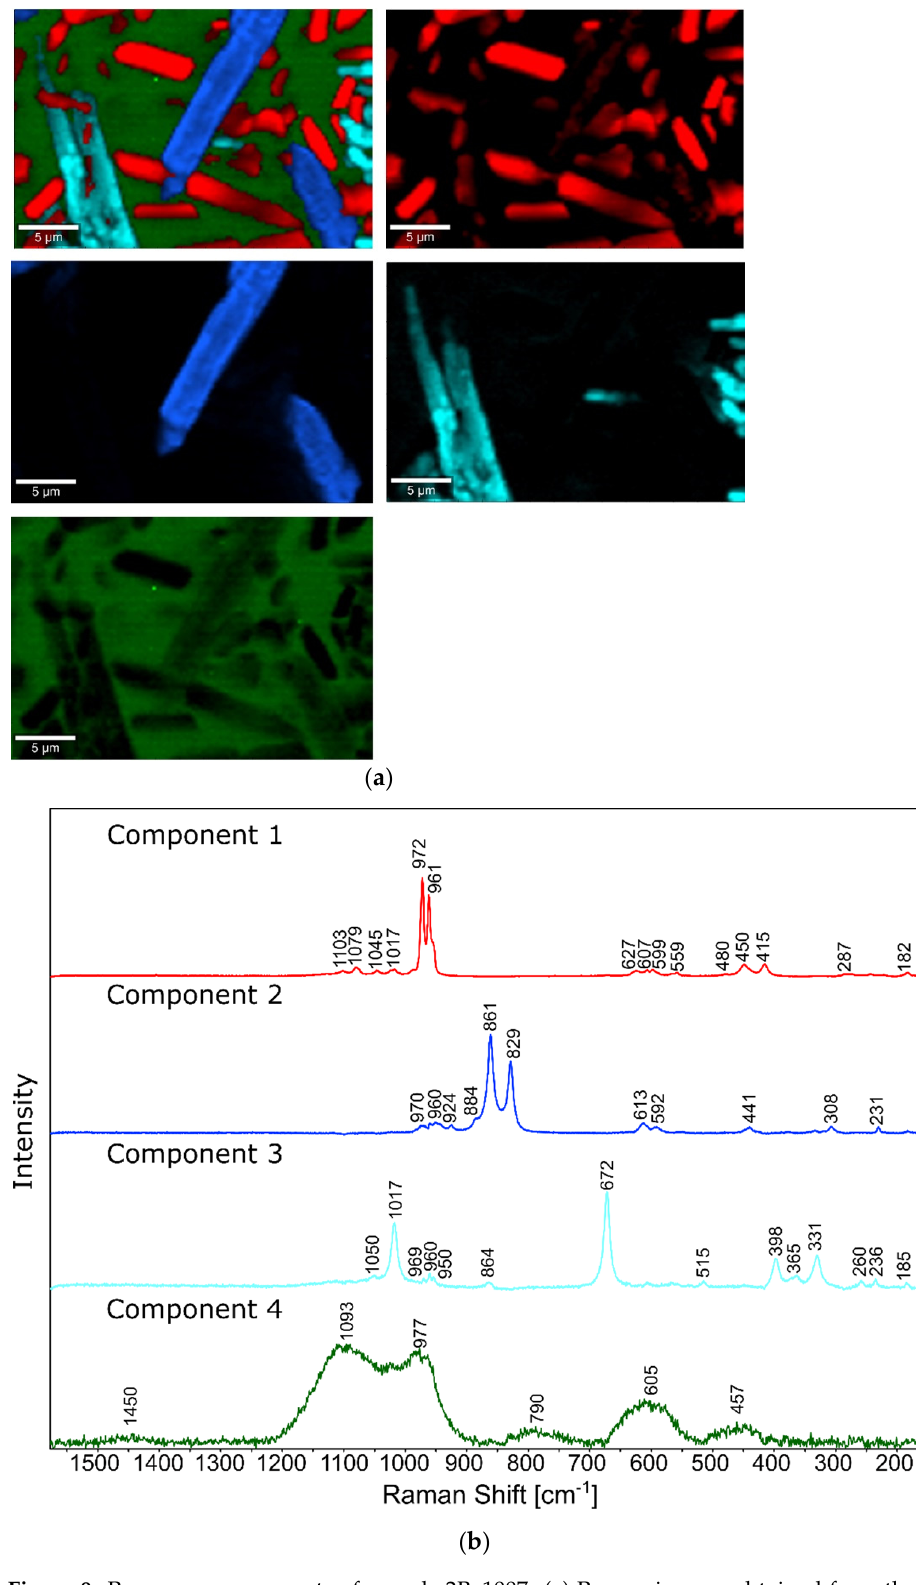
Figure 9. Raman measurements of sample 2B_1007. ( a ) Raman images obtained from the cluster analysis and ( b ) average Raman spectra from corresponding clusters: Component 1—Ca 9 MgK(PO 4 ) 7 -whitlockite structure type, Component 2—Mg 2 SiO 4 -forsterite type, Component 3—CaMgSi 2 O 6 -diopside type, Component 4—glass matrix.